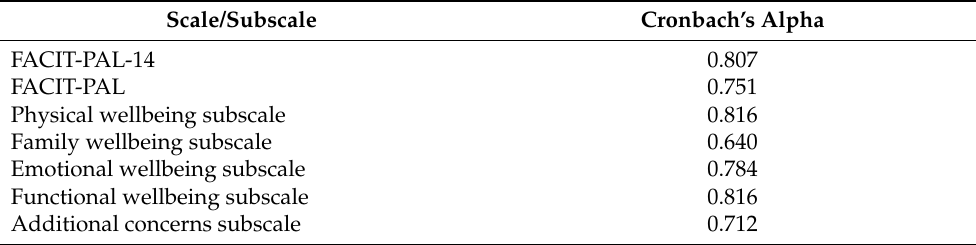
Table 2. Internal consistency with Cronbach’s alpha coefficient.